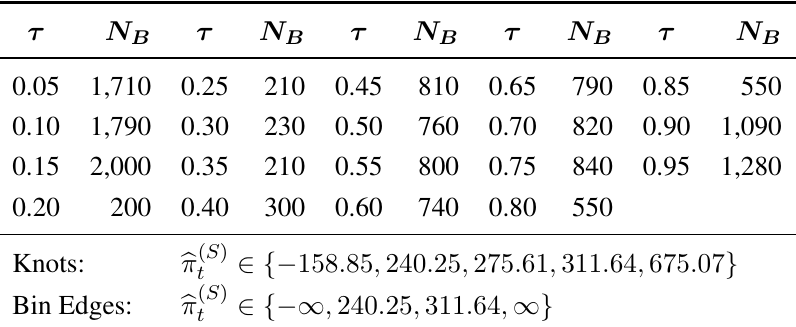
) found for each value of τ . B